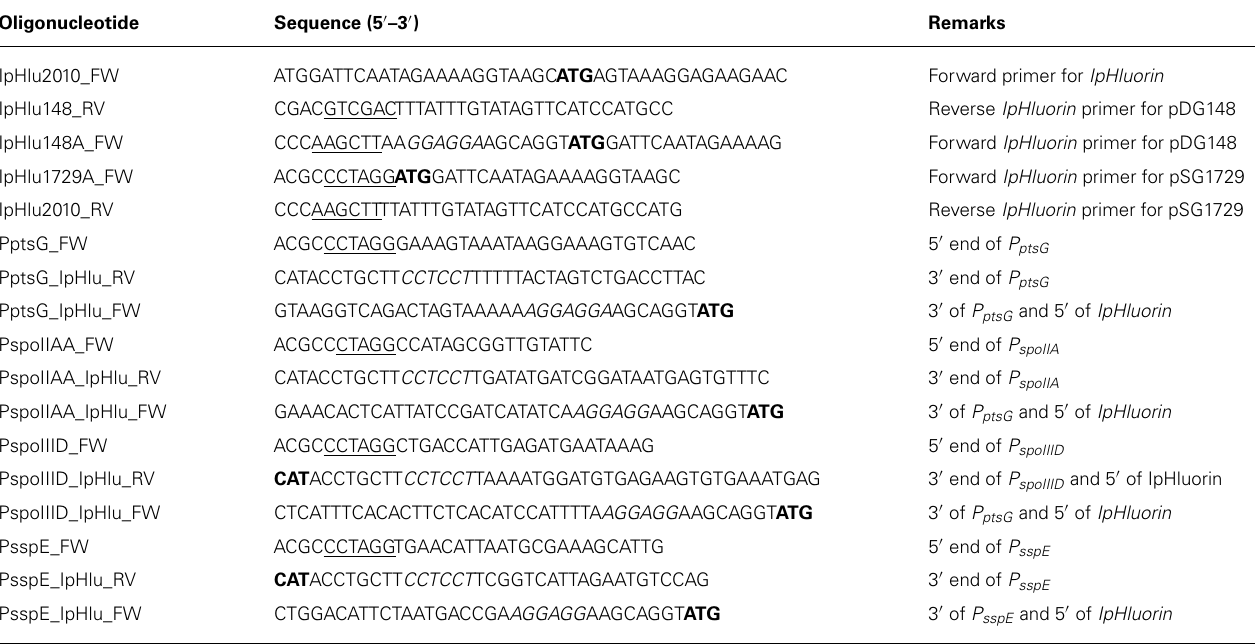
Table 3 | Oligonucleotides used in this study. Oligonucleotide Sequence (5 (cid:2) –3 (cid:2)